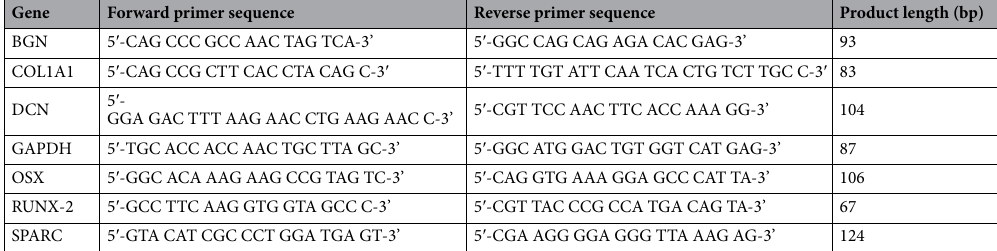
Table 1. Oligonucleotide primers used for qPCR amplification. BGN biglycan, COL1A1 collagen type I, DCN decorin, GAPDH glyceraldehyde 3-phosphate dehydrogenase, OSX osterix, RUNX-2 runt-related transcription factor 2, SPARC